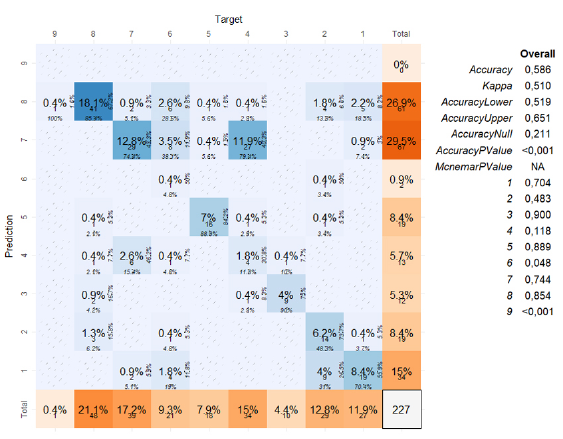
Figure 2. Confusion matrix relating embodied im- pact parameters (reference) to predicted integrated life cycle impacts (UBiM). Model accuracy = 58.6 %.